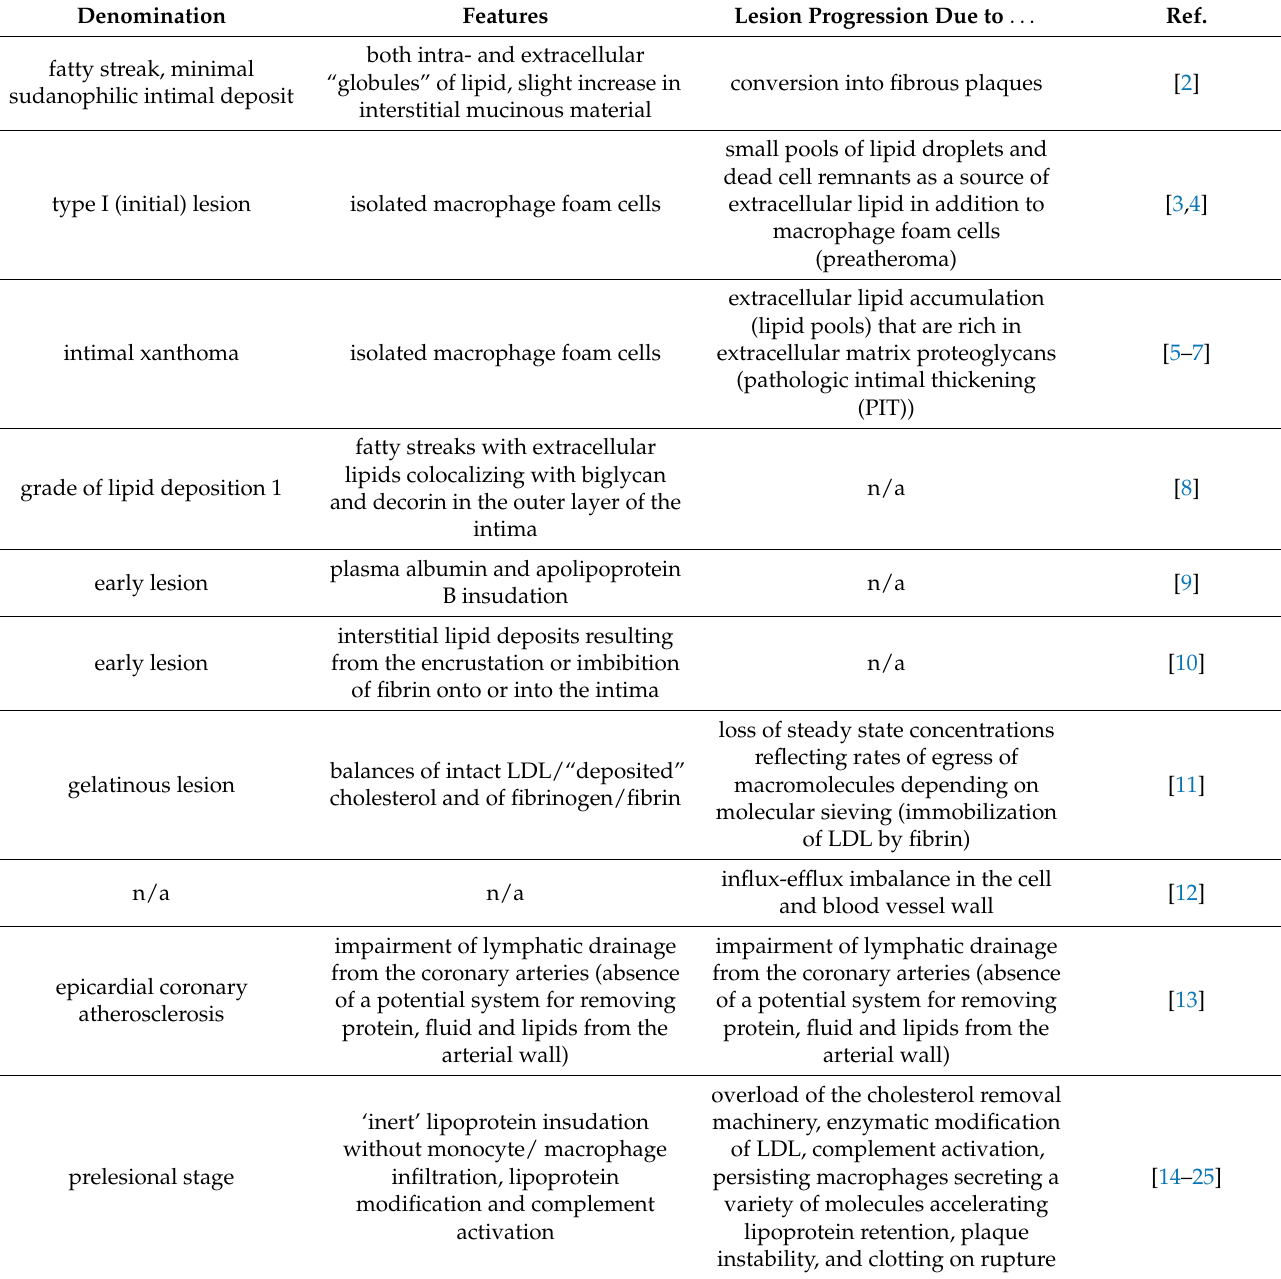
Table 1. Concepts on initiation and/or progression of human atherosclerotic lesion. Denomination: terminology used to describe the beginning of atherosclerotic lesion development. Features: hallmarks and triggers of lesion initiation. Lesion progression due to . . . : hallmarks and triggers of lesion progression (provided that lesion progression is considered). Denomination Features Lesion Progression Due to . . .